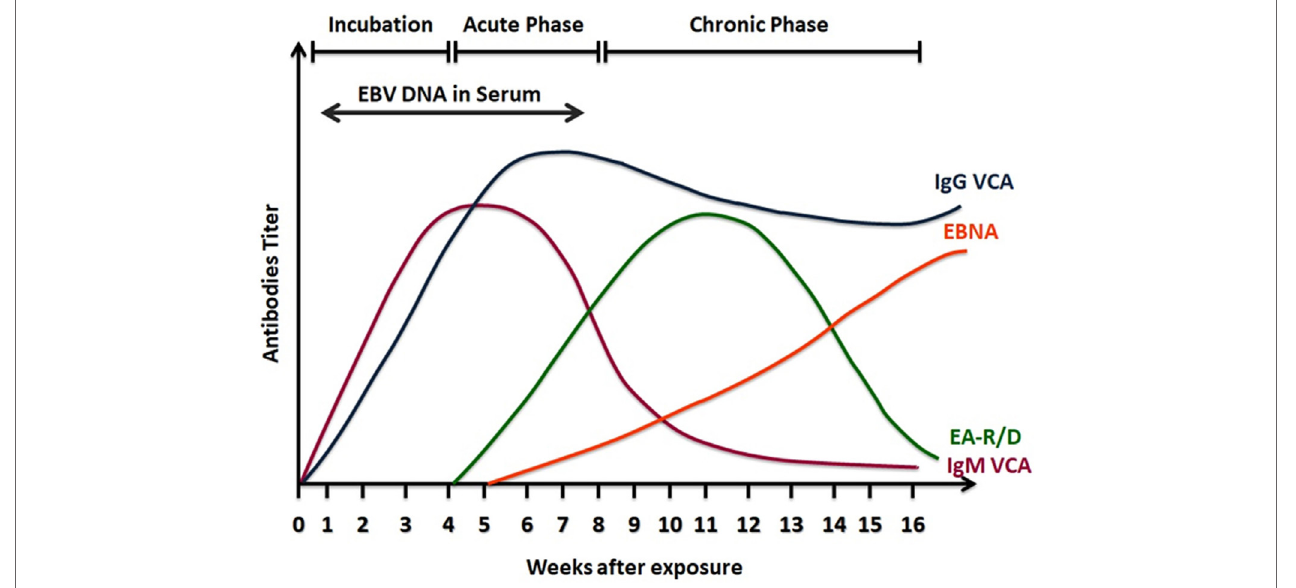
FiGURe 3 | A scheme of serological response to Epstein–Barr virus (EBV) infection. Viral capsid antigens (VCA)-IgM is detected in the active phase of infection and then declines in convalescence. VCA-IgG increases at the same time of VCA-IgM, but it remains positive for life indicating past infection. Epstein Barr nuclear antigens (EBNA) antibodies are detectable late in the phase of infection and also remain positive. Early antigens (EA) antibodies to the class R or D increase in the acute phase of infection and decline after